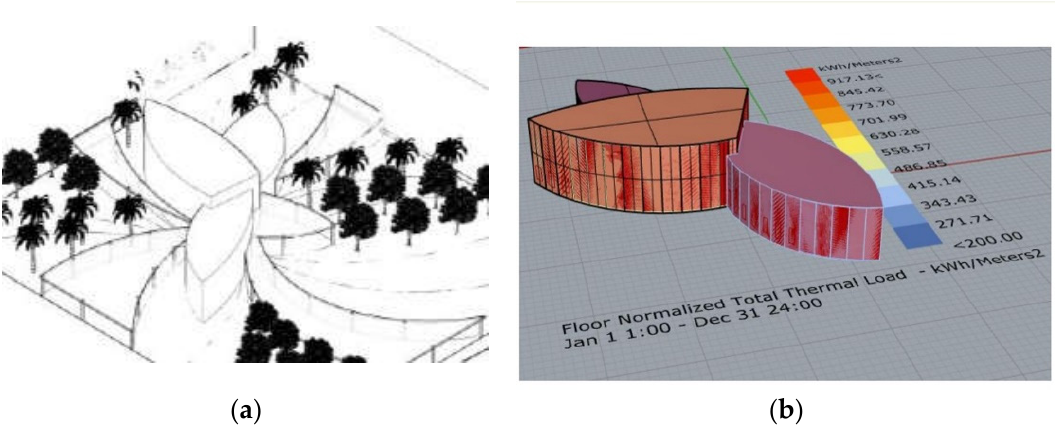
Figure 17. ( a ) Model of the library extension in REVIT, ( b ) simulation in RHINO.